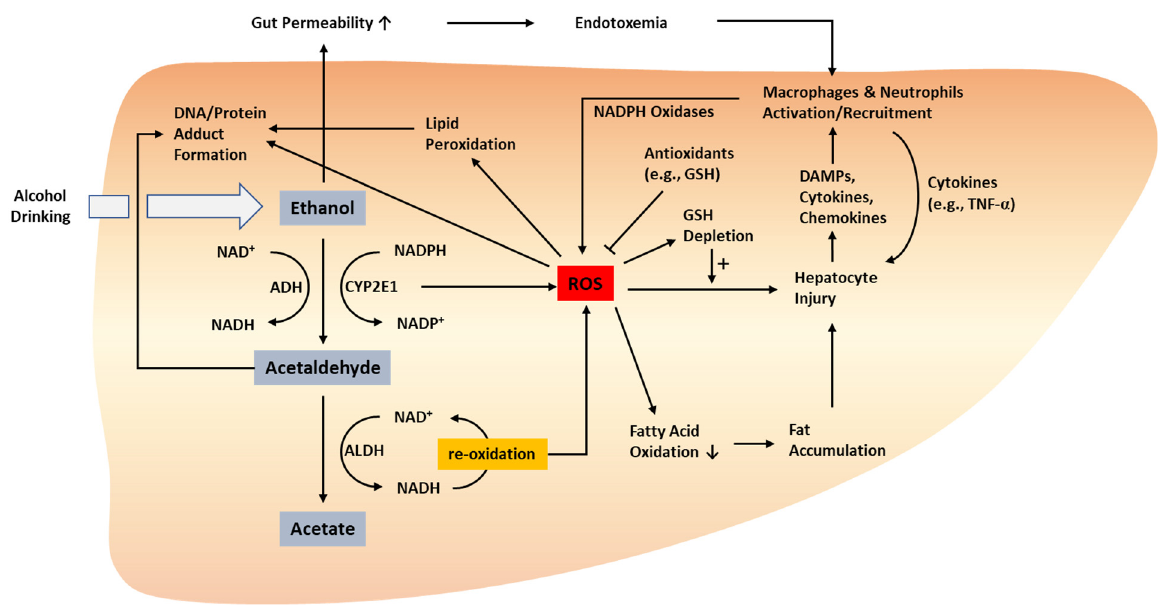
Figure 1. Oxidative stress-related pathogenesis of ALD. ROS can be produced by the metabolism of ethanol to acetaldehyde and acetate as well as the related processes that involve the conversion between NAD + /NADP + and NADH/NADPH. ROS produced via these processes stimulate hepatocyte injury directly or via enhanced fat accumulation. Injured hepatocytes release DAMPs, cytokines, and chemokines, which activate and recruit innate immune cells such as macrophages and neutrophils. Activated macrophages and neutrophils can also produce ROS via NADPH oxidase. Protein and DNA adducts formed by acetaldehyde and ROS may facilitate liver injury, inflammation, and carcinogenesis. ADH, alcohol dehydrogenase; ALD, alcoholic liver disease; ALDH, aldehyde de- hydrogenase; DAMP, damage-associated molecular pattern; GSH, glutathione; ROS, reactive oxygen species; TNF- α , tumor necrosis factor-alpha. ↑ , increased; ↓ ,